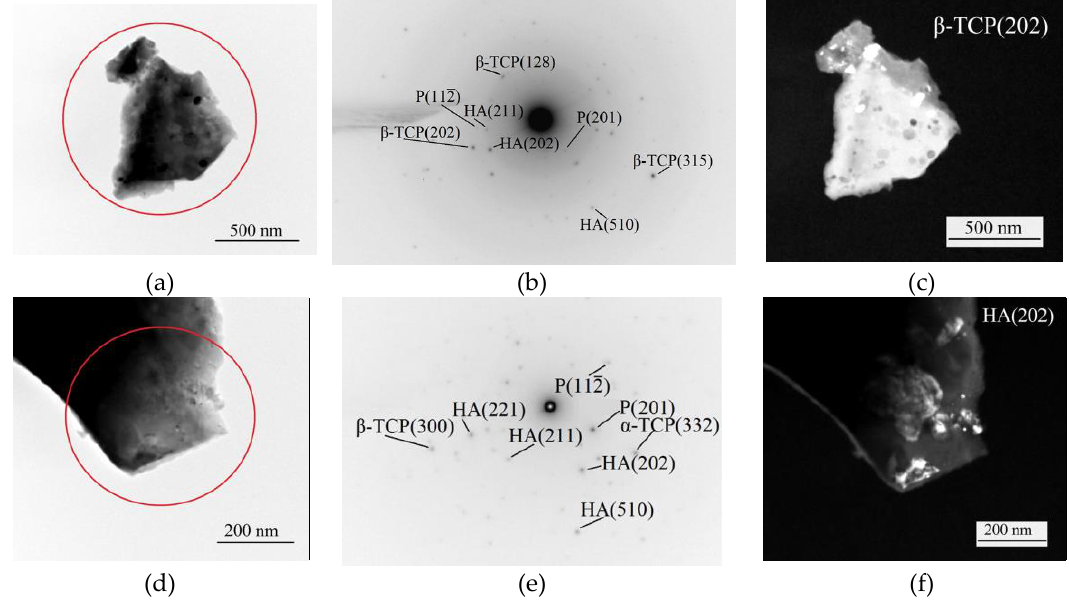
Figure 6. The bright-field ( a , d ), dark-field ( c , f ) transmission electron microscope (TEM) images and selected area diffraction (SAD) pattern ( b , e ) of the Sr-HA ( a – c ) and Sr-TCP ( d – f ) coatings deposited at 400 V.